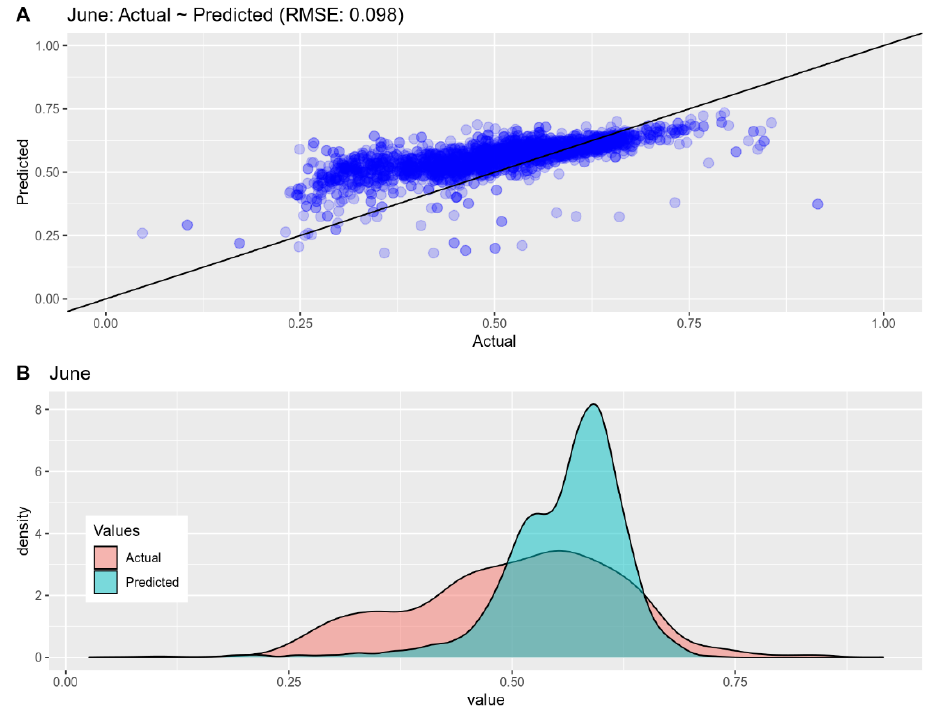
Figure A6. Comparison between actual~predicted for June 2020.